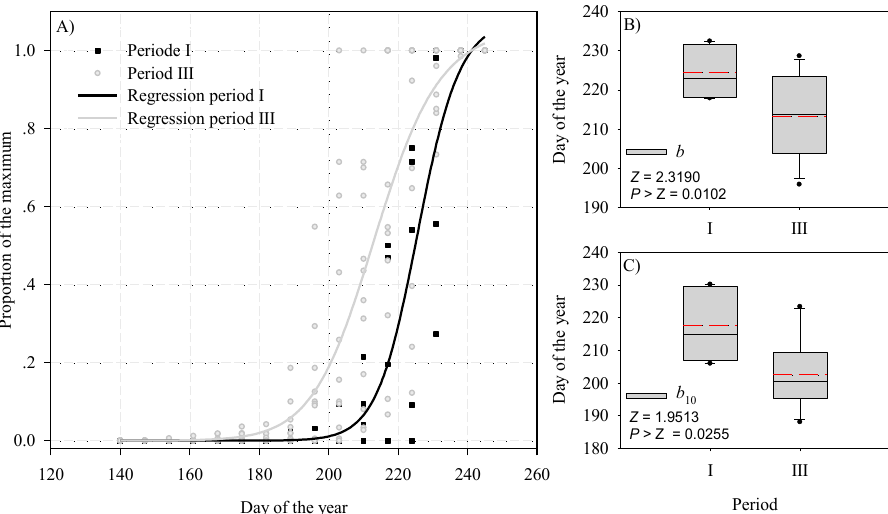
Figure 3. ( A ) Disease progress curves for the first and third ODM periods. Box plots of ( B ) model parameter estimate b , which represents the time (in days) at which seasonal ODM incidence is half of its maximum value (mid-time) and ( C ) b 10 , the time (in days) when seasonal ODM incidence is equal to 10% of the maximum value (10% epidemic onset). Period I include the years 1987–1996, and period III, 2007–2017. In each box plot, the horizontal black lines, from bottom to top, represent the 10th, 25th, 50th (median), 75th and 90th percentiles, the red dashed line represents the mean and a black circle represents an outlier. The Z statistic and associated p -value are for the Wilcoxon exact test (significance level α = 0.05).